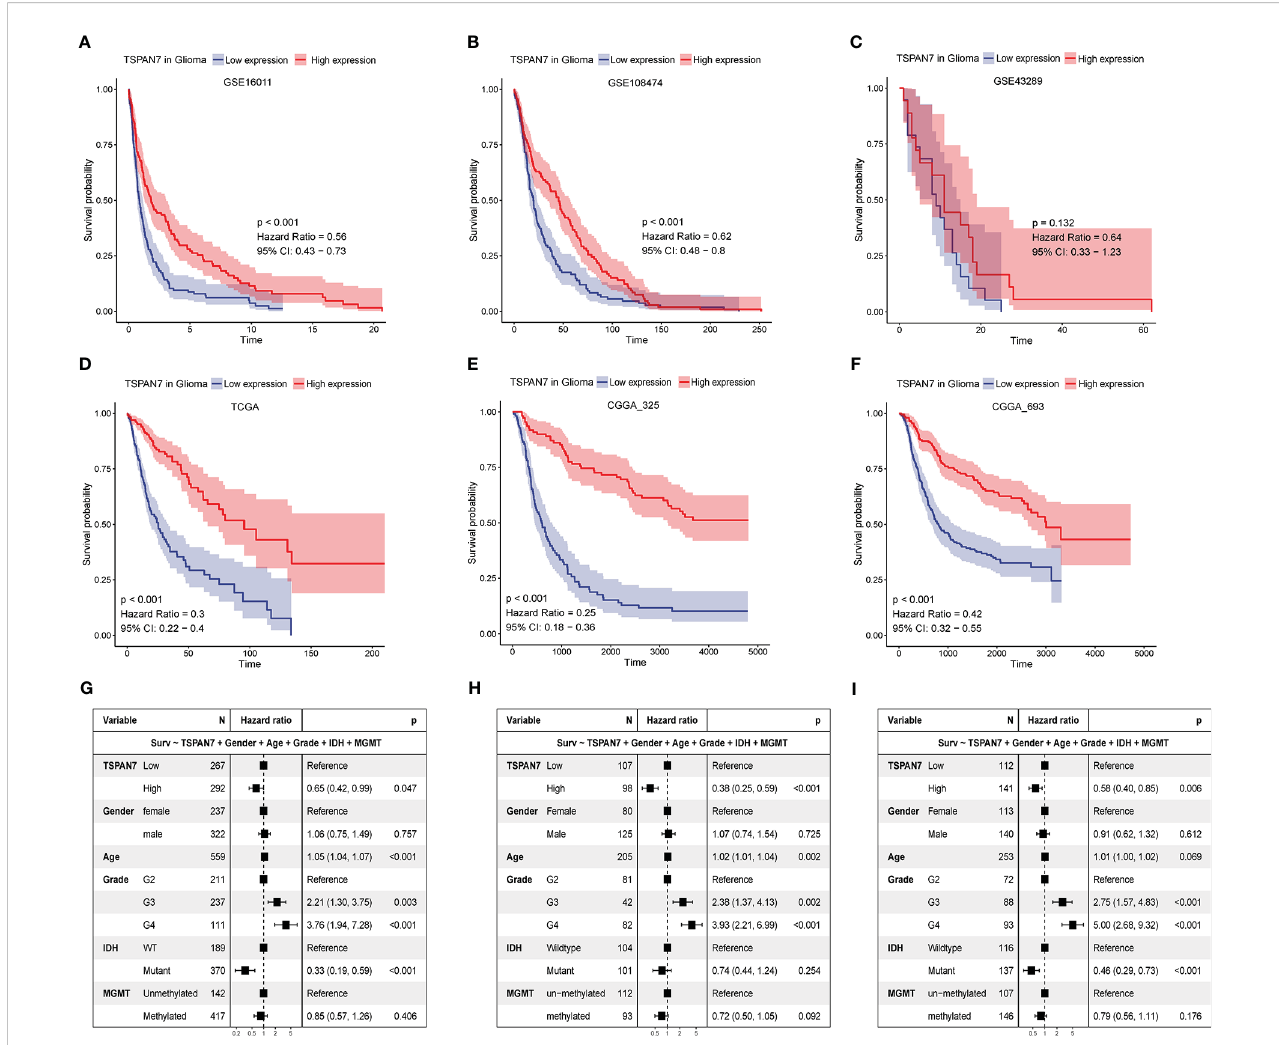
FIGURE 3 The relationship between TSPAN7 expression and survival for glioma. (A-F) Kaplan – Meier plots of TSPAN7 in (A) GSE16011, (B) GSE108474, (C) GSE43289, (D) TCGA, (E) CGGA_325 and (F) CGGA_693datasets. (G-I) The forest diagrams represent the multi-factor COX regression analysis, in which the variables include TSPAN7, gender, age, pathological grade, IDH mutation status and MGMT methylation status in TCGA (G) , CGGA_325 (H) , CGGA_693 (I)